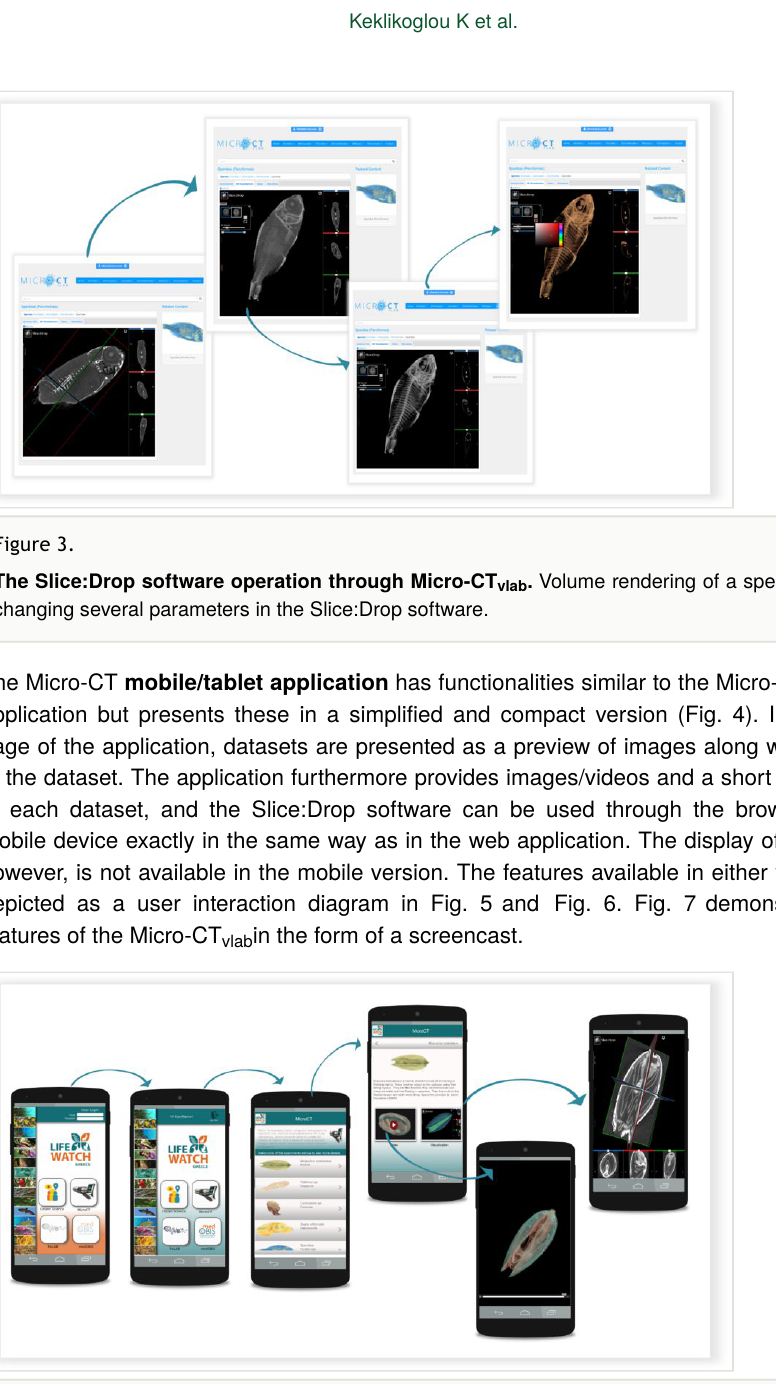
Micro-CT mobile/tablet application and its